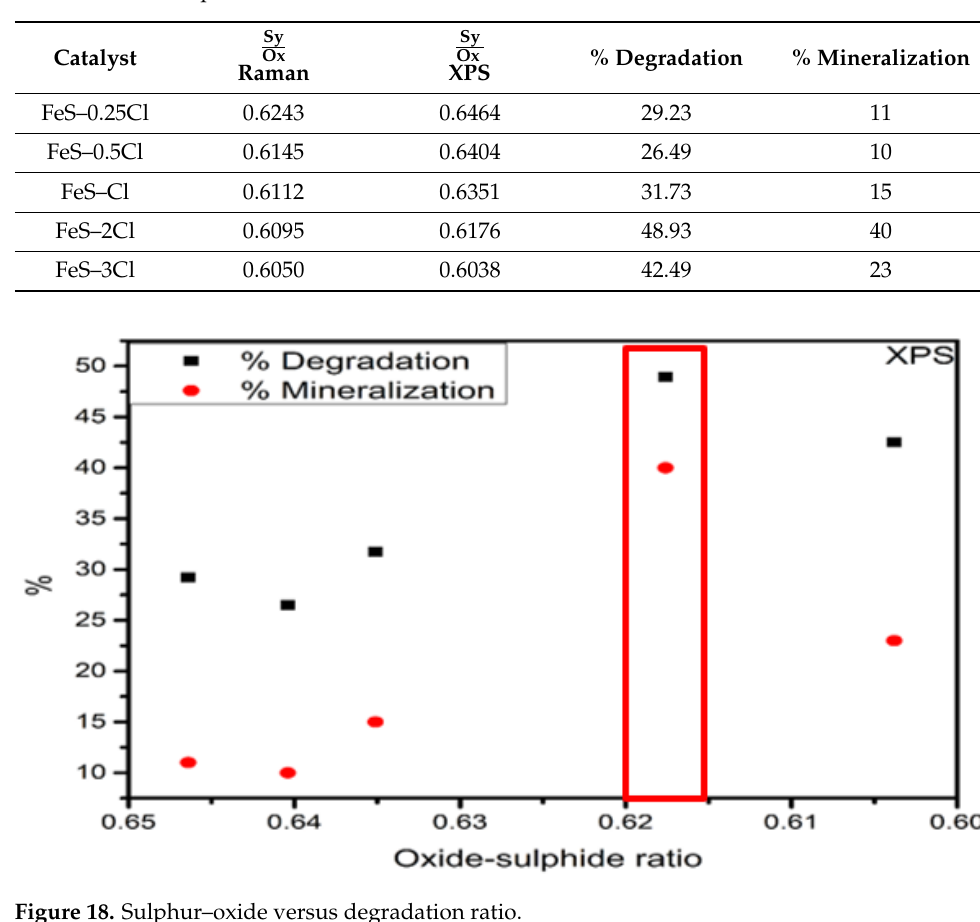
Figure 18. Sulphur–oxide versus degradation ratio.